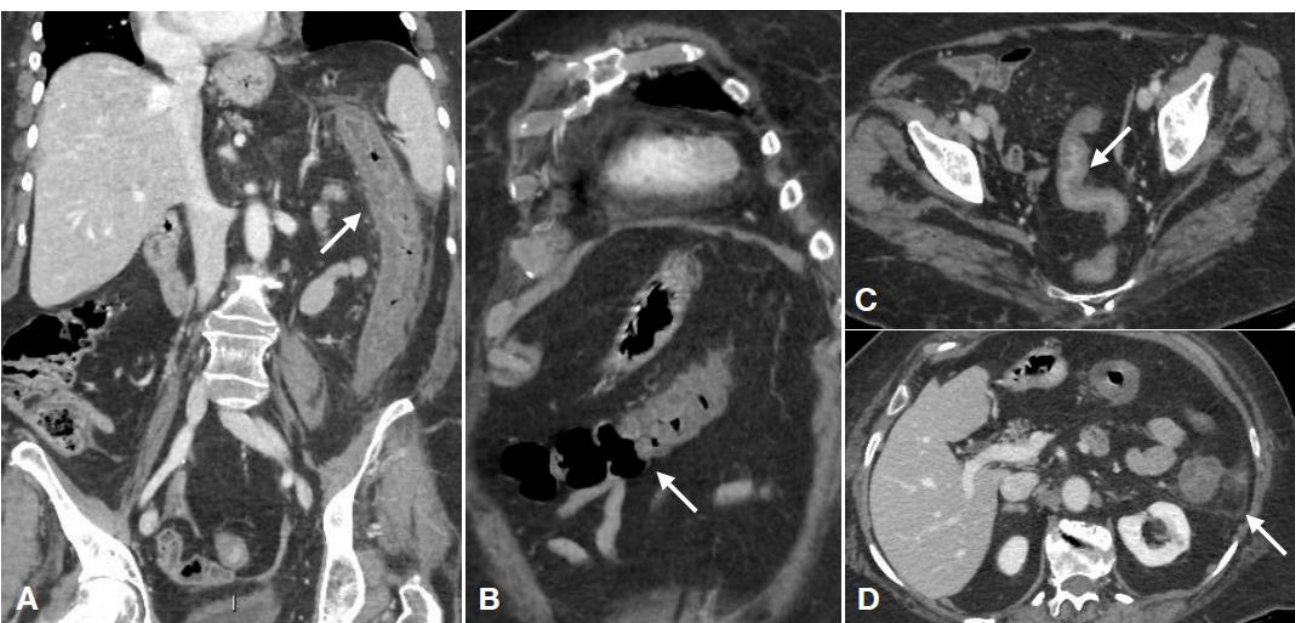
Figure 1. Enhanced CT of a 50-year-old female presenting with abdominal pain and rectorrhagia showing typical CT findings of ischemic colitis. ( A , B ) Portal-venous phase in coronal view shows continuous thickening of the colonic wall with mucosal hyperemia, submucosal edema and reduced lumen (( A – D ), arrows). ( B , C ) There is involvement of the whole left colon, with a clear distinction between the affected and unaffected segment (( B ), arrow), and the coexistence of pericolic fat stranding (( C ), arrow). ( D ) In the axial plane is clearly evident the “little rose” sign (( D ), arrow). These findings are consistent with ischemic left colitis with reperfusion. No significant vessel findings were detected.